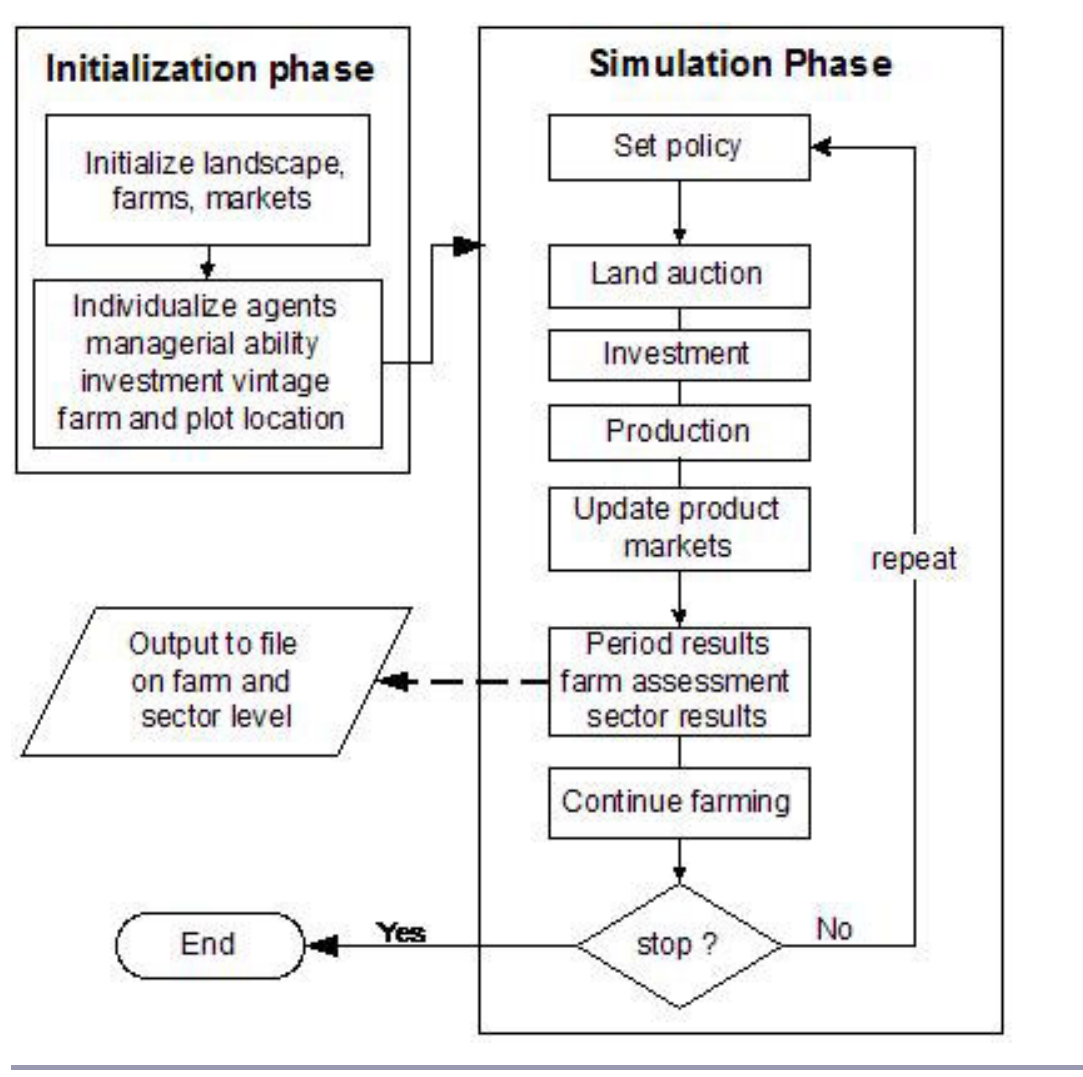
Fig. 2. Model dynamics and course of events during one